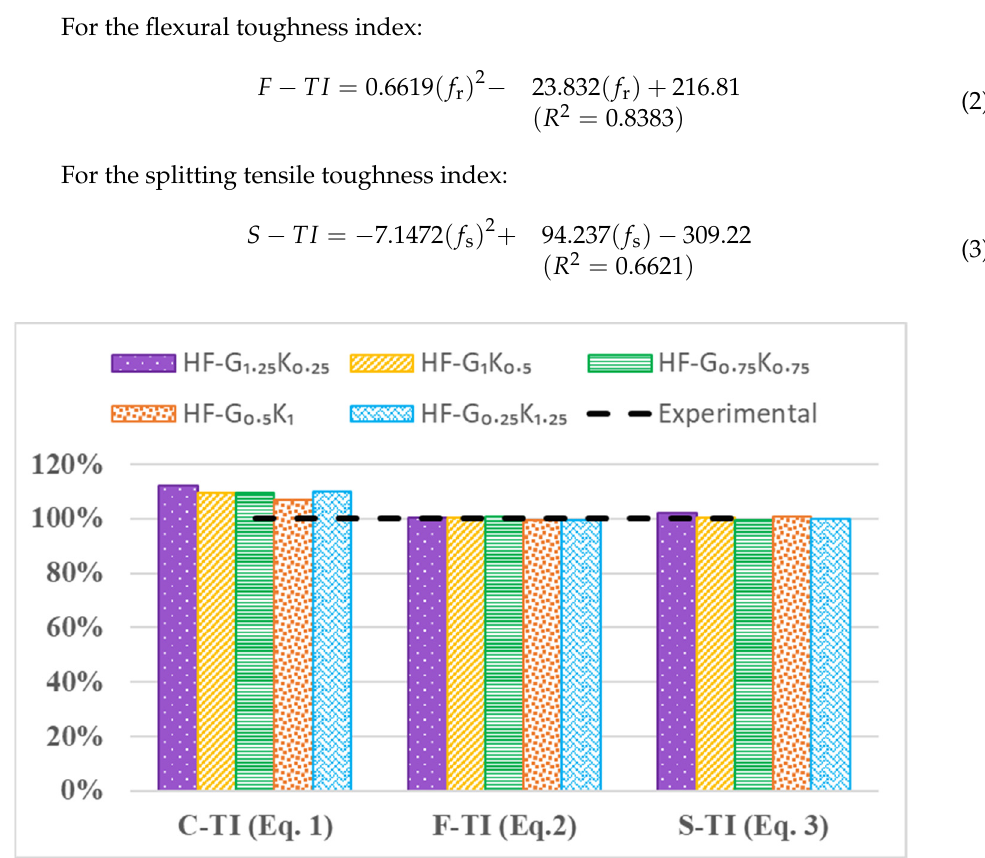
Figure 14. Comparison of the HPHFRC’s experimental and empirical toughness index values .